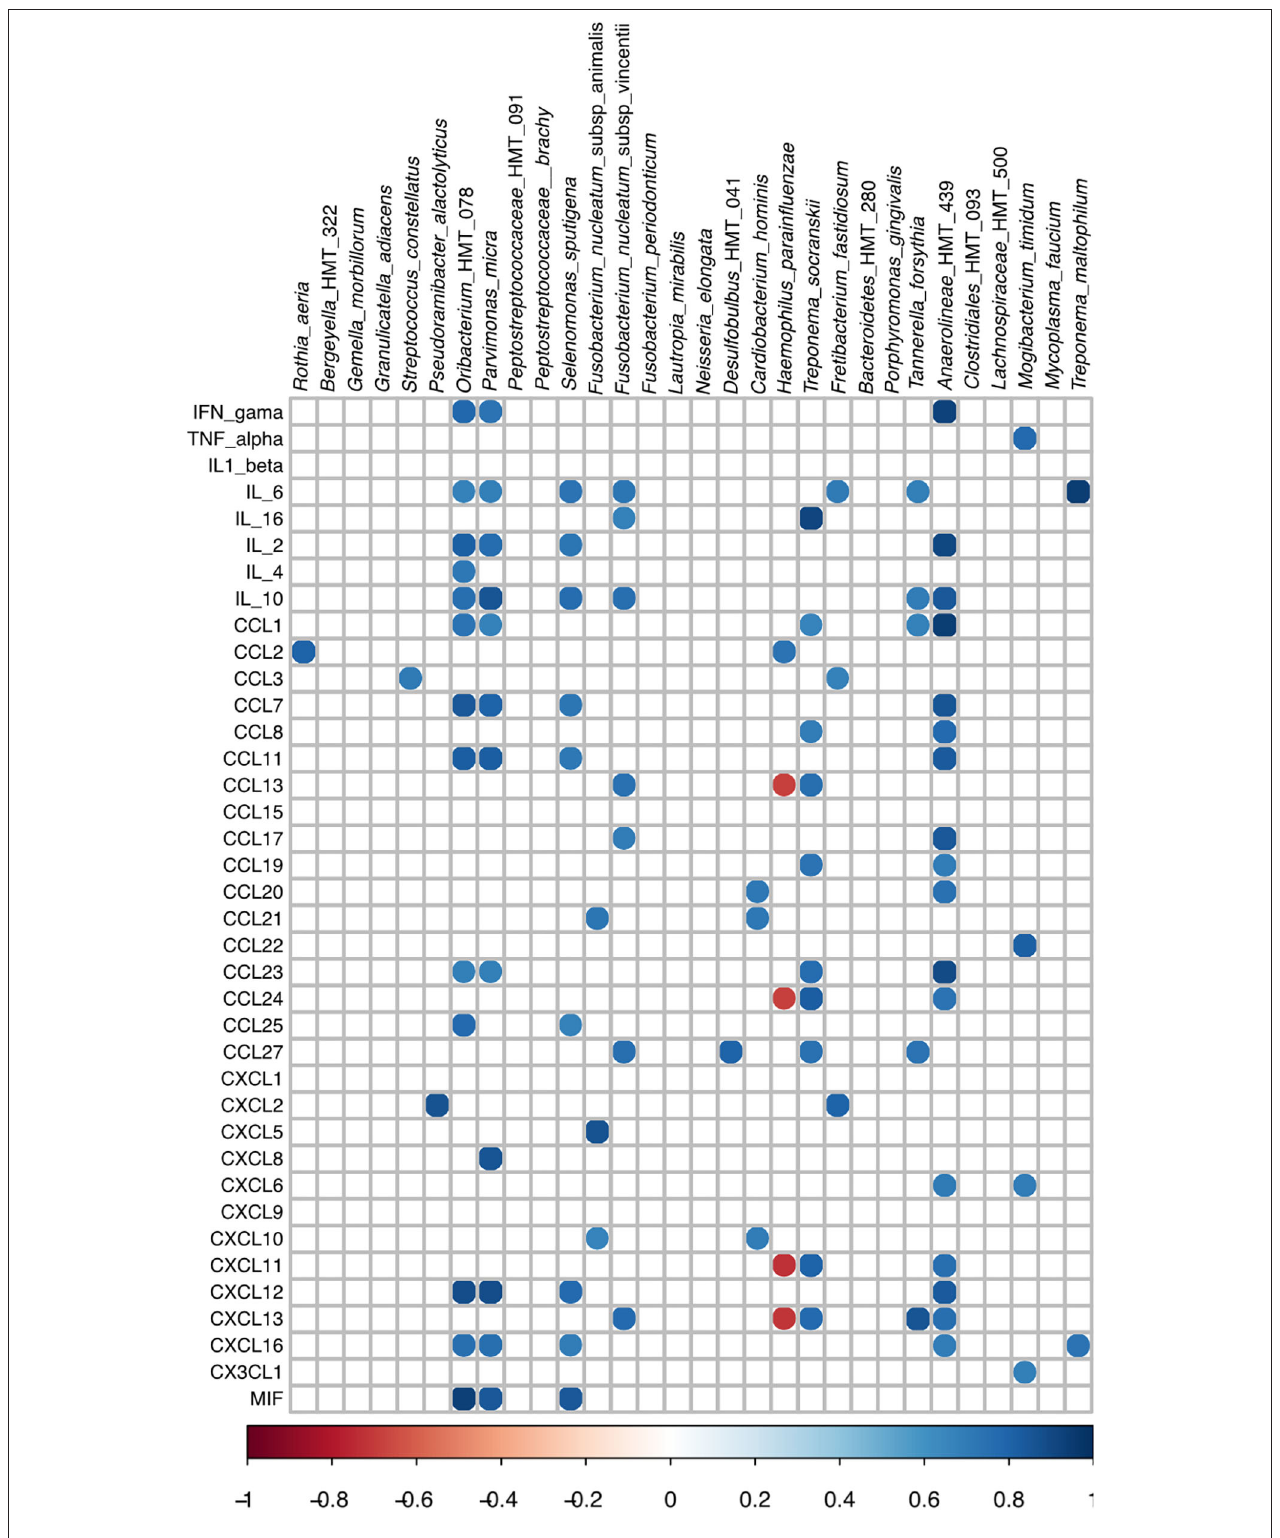
FIGURE 4 | Spearman Rho correlation among RA values of subgingival bacteria and cytokines/chemokines levels in saliva of periodontitis subjects. Only species more or less abundant in subgingival affected sites of periodontitis than in subgingival sites of the healthy patients were evaluated.